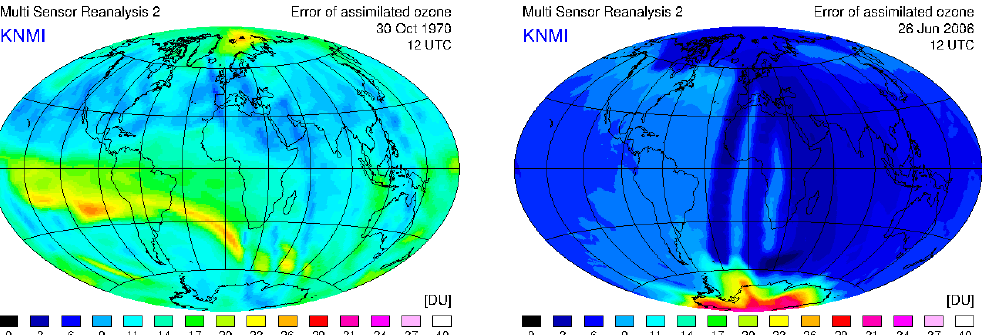
Figure 5. The instantaneous error field during the assimilation of the ozone data for the MSR2 at 12:00UTC on 30 October 1970 (left panel) when satellite data are sparse and on 26 June 2006 (right panel) when the number of satellite observations is more or less at its peak. The location of the most recent assimilated measurements coincides with the lowest errors. The model error term leads to an increase of the forecast error with the time passed since the last analysis. The advection of the error is visible as distortions of the orbit shape.